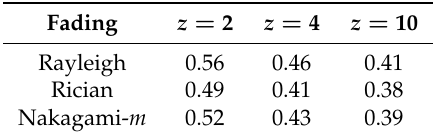
Figure 5. Channel Utilization when z = 2,4,10. ( a ) Assume all the collided slots are only caused by two packets; ( b ) Collided slots are caused by two or more packets in practice. Table 2. Theoretical maximum channel utilization.